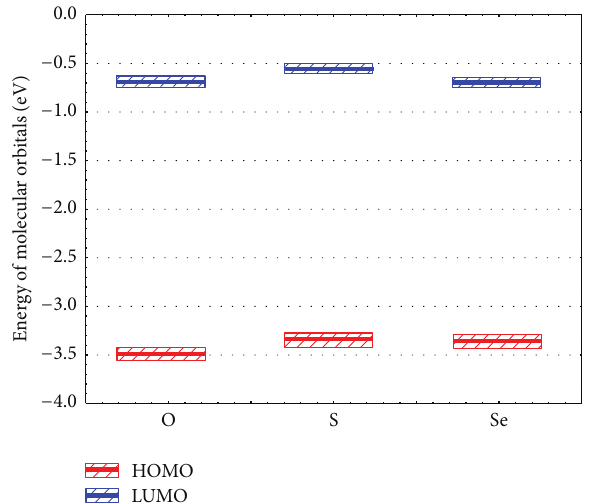
Figure1:Orbitalenergiesdiapasonsfor[1,2,5]oxadiazolo[3,4- c ]pyr- idine (O), [1,2,5]thiadiazolo[3,4- c ]pyridine (S), and [1,2,5]selenadia- zolo[3,4- c ]pyridine (Se) derivatives.